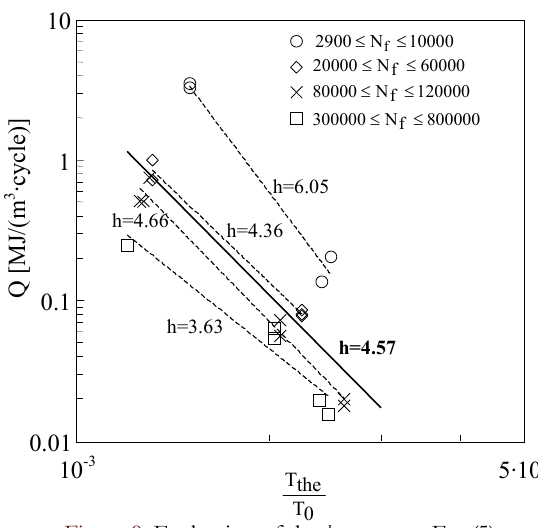
Figure 9: Evaluation of the h constant, Eq. (5).